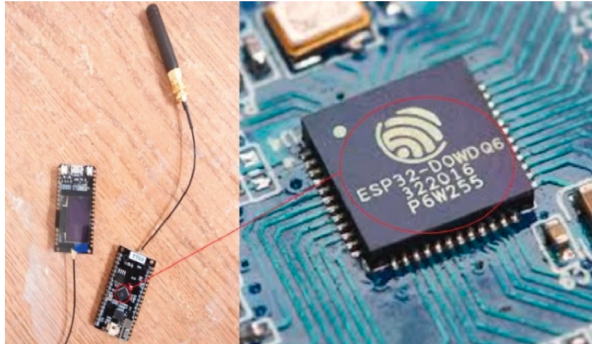
Figure 13: ESP32 with LoRa module used for AES